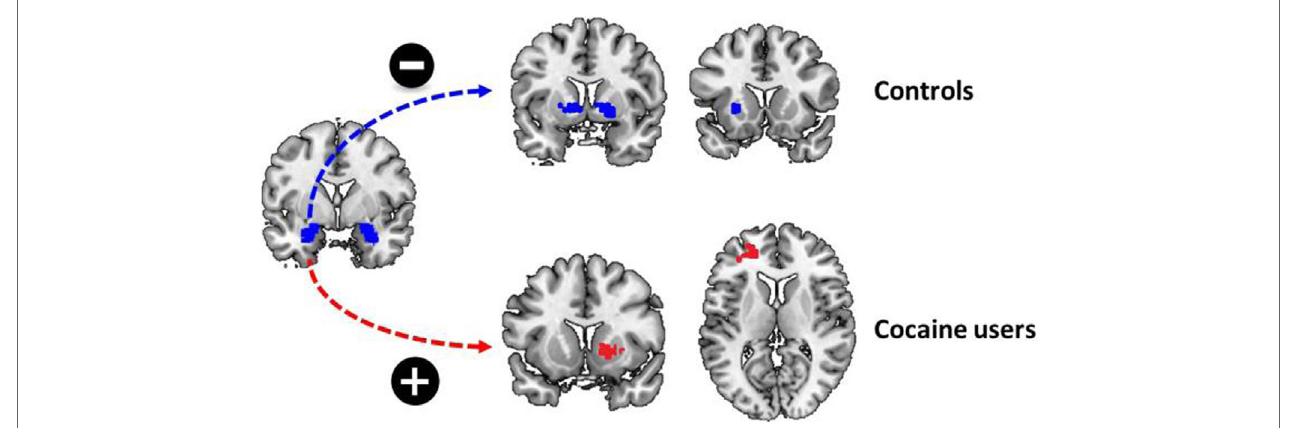
FigUre 3 | Childhood trauma and functional connectivity. There was a significant group by childhood trauma interaction on functional connectivity between the left amygdala and the dorsal striatum. While childhood trauma was negatively correlated with functional connectivity between the left amygdala and bilateral dorsal striatum in non-drug using controls, childhood trauma was positively correlated with functional connectivity between the left amygdala and left middle frontal cortex and right dorsal striatum.